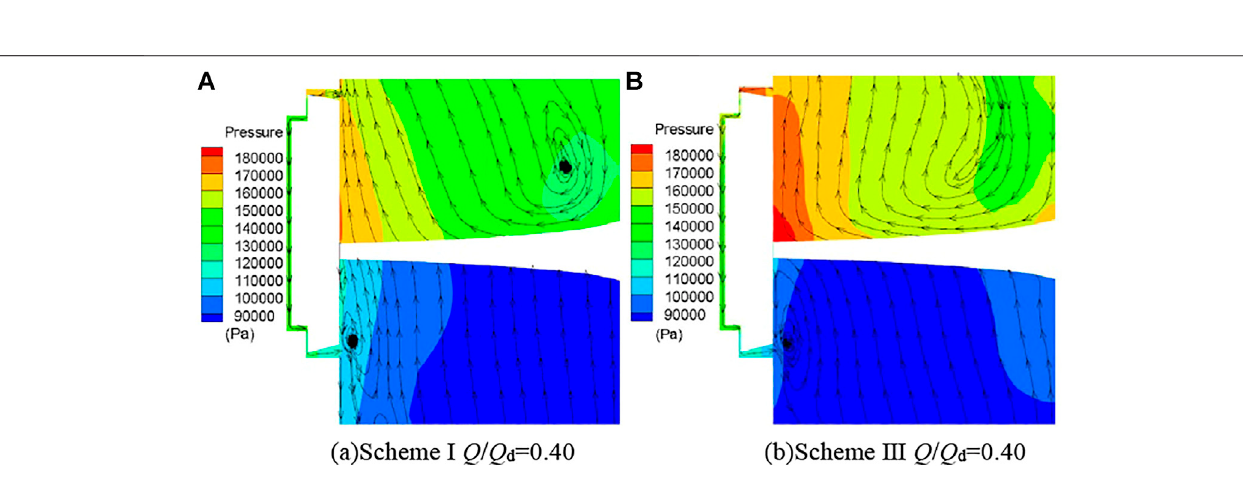
Frontiers in Energy Research |